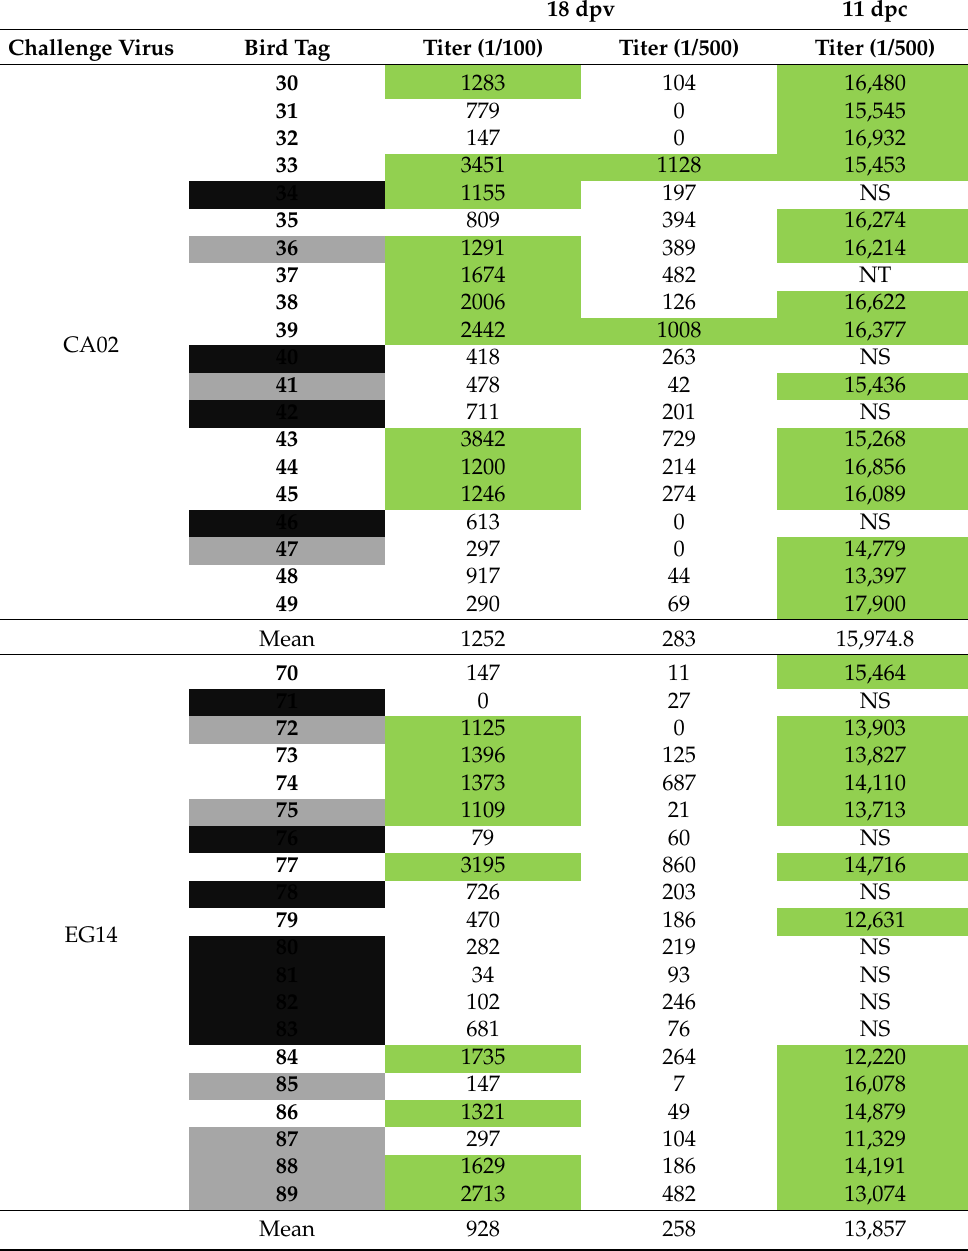
Table 1. ELISA titers from birds vaccinated with adeno-F at high dose before and after challenge with the three different NDV isolates. Birds found dead or euthanized are highlighted in black and birds displaying any clinical signs are highlighted in dark gray. Positive sera at 18 days dpv and at 11 dpc by ELISA test using 1/500 or 1/100 dilutions are highlighted in green. ELISA was tested using 1/500 dilution at 11 dpc. 18 dpv 11 dpc Challenge Virus Bird